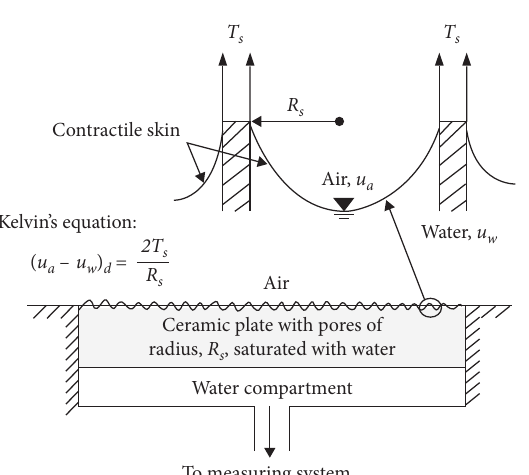
Figure 4: Operating principle of a high air entry plate as described by Kelvin’s capillary model